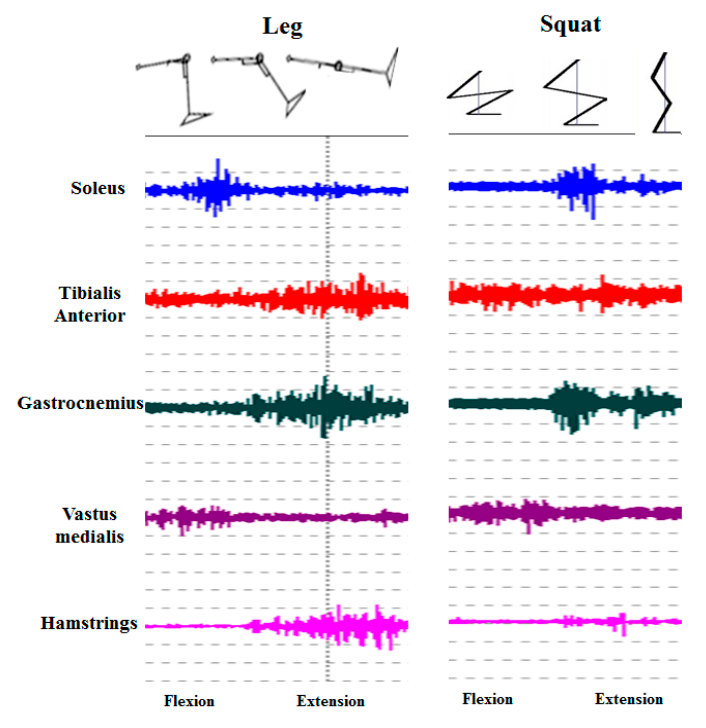
Figure 5. EMG result showing the muscle patterns upon Leg-link system and Squat